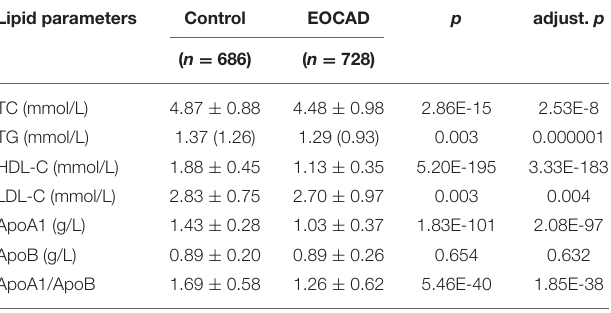
TABLE 2 | Serum lipid levels of participants. Lipid parameters